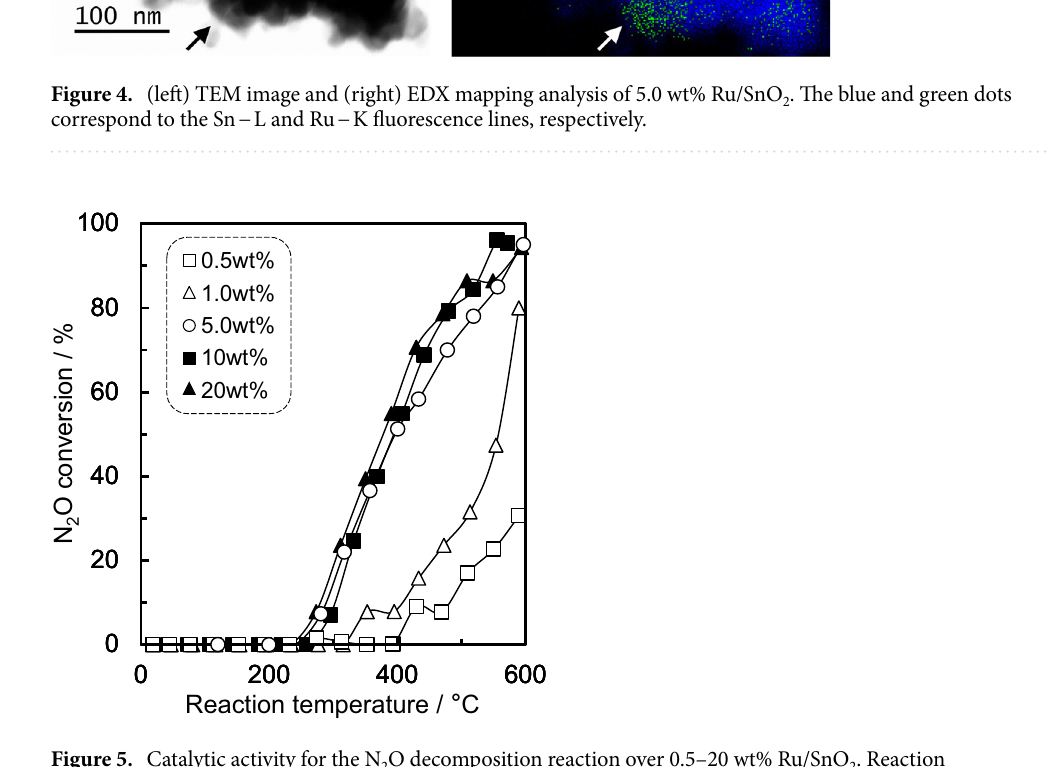
Figure 5. Catalytic activity for the N 2 O decomposition reaction over 0.5–20 wt% Ru/SnO 2 . Reaction conditions: 200 ppm of N 2 O, 10% O 2 and N 2 balance at 100 cm 3 ·min −1 (W/F = 5.0 × 10 −4 g·min·cm −3